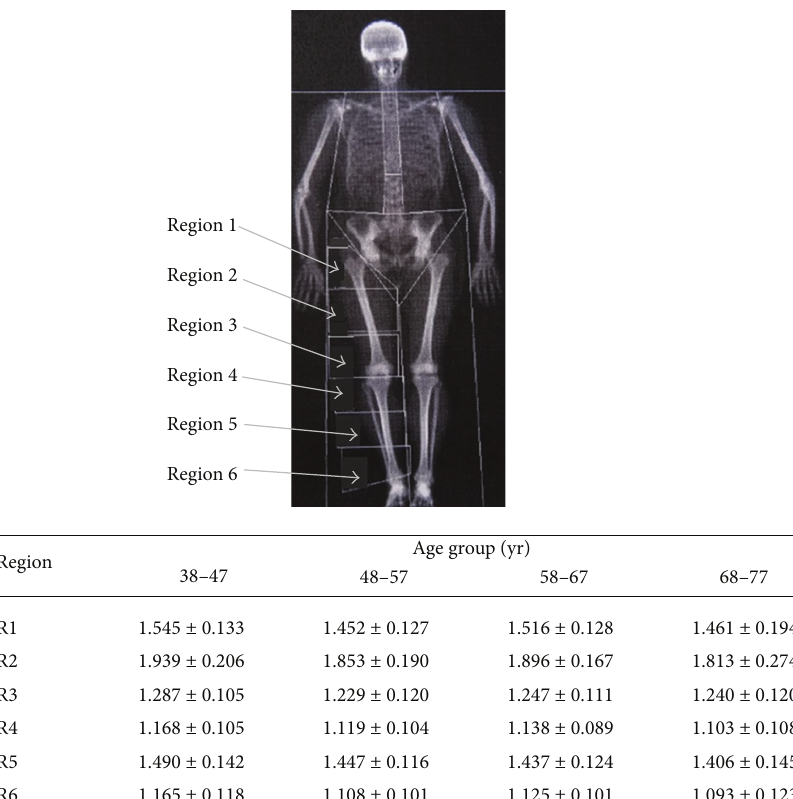
Figure 1: Designation of regions of the lower limb skeleton (Regions 1–6) with data for control subjects. Only the regions on the right side are depicted in the figure. The associated table shows the mean bone mineral density measurements for the control group from which 𝑧 scores were calculated. The measurements show the average of the right and left side combined (mean ± SD) according to region and age